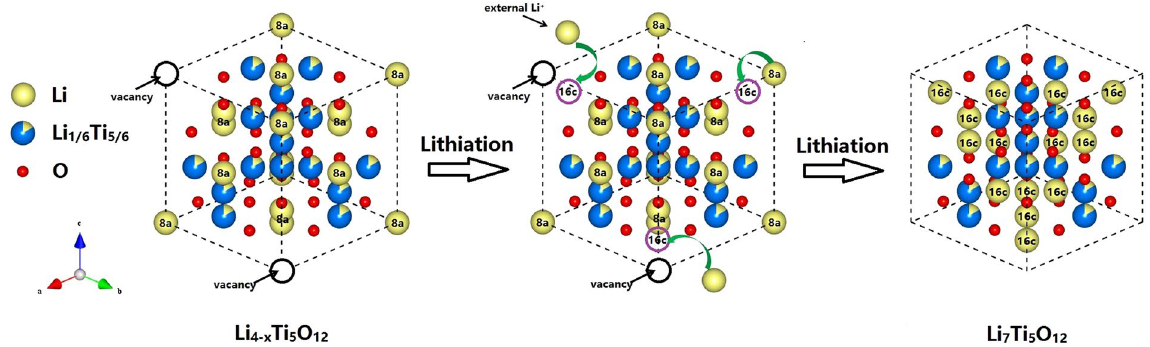
Figure 7. A schematic illustration of lithiation process from Li 4 − x Ti 5 O 12 to Li 7 Ti 5 O 12